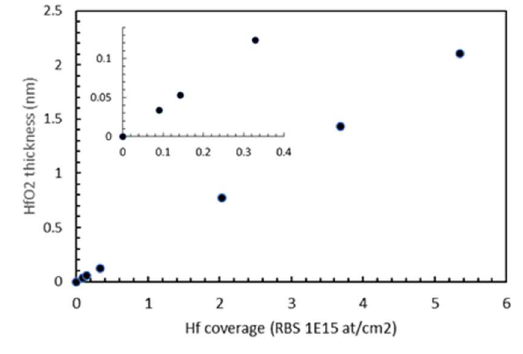
Figure 2 : Thickness calculation based on XPS data of a HfO 2 layer deposited on SiO 2 correlated to the amount of deposited material as measured by RBS